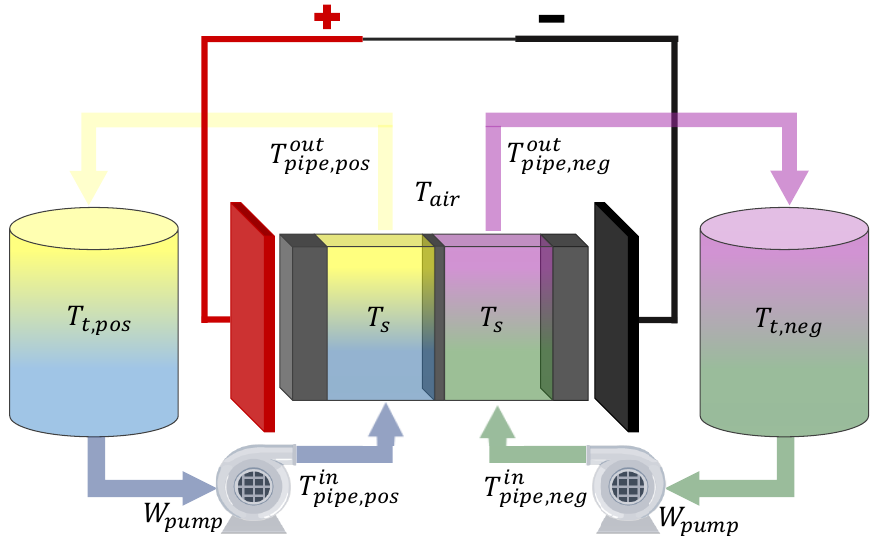
Figure 4. Scheme of a VRFB with the temperatures involved in the thermal